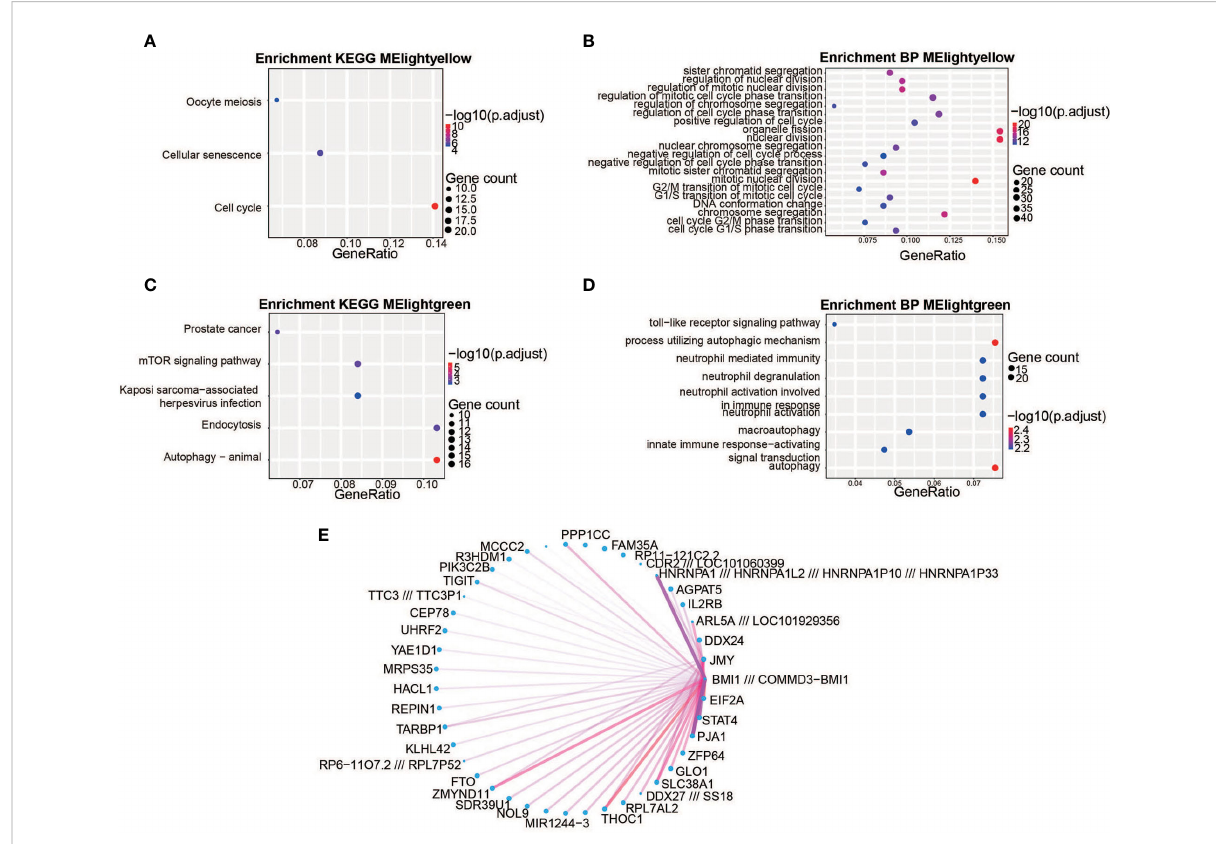
FIGURE 2 The biological signi fi cance of the light-yellow and light-green module genes. (A, C) Kyoto Encyclopedia of Genes and Genomes (KEGG) enrichment analysis. The light-yellow module genes were signi fi cantly enriched in the cell cycle (A) and the light-green module genes were signi fi cantly enriched in their autophagy pathways and endocytosis (C) . The color represents the -log 10 (adjustment of p -value) values and the size of the dot represents the size of corresponding pathways and gene counts. (B, D) Gene Ontology (GO) enrichment analysis. The light-yellow module was signi fi cantly associated with nuclear division and organelle fi ssion (B) and the light-green module was mainly involved in the autophagy process (D) The different colors represent the -log 10 (adjustment of p -value) values and the size of the dot represents the size of corresponding pathways and gene counts. (E) Weighted co- expression gene networks are represented by the light-yellow module. The width of the line represents gene – gene interaction weight and the size of the dot represents the gene degree. JMY is the hub gene for the light-green